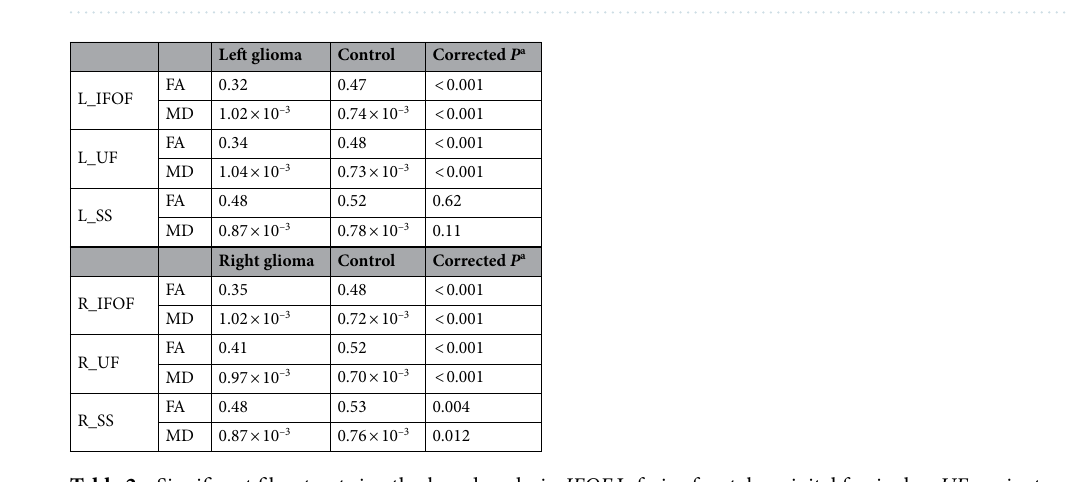
Table 2. Significant fiber tracts in atlas based analysis. IFOF Inferior frontal-occipital fasciculus, UF uncinate fasciculus, SS sagittal stratum. a Student’s t-test, FWE corrected.